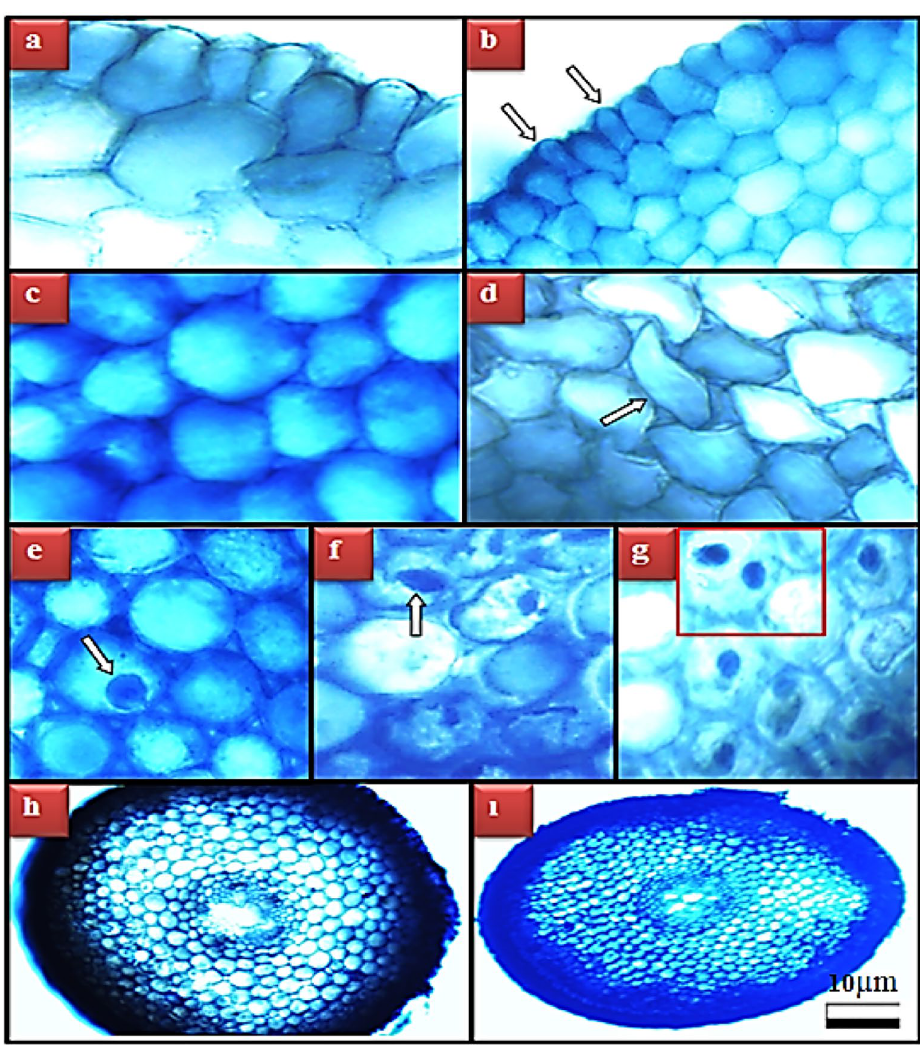
Figure 6. Meristematic cell damages induced by glyphosate. Normal appearance of epidermis cells ( a ), epidermis cell damage ( b ), normal appearance of cortex cells ( c ), cortex cell damage ( d ), normal appearance of cell nucleus-oval ( e ), flattened cell nucleus ( f ), binuclear cell ( g ), normal appearance of the vascular tissue ( h ), irregular vascular tissue ( i ).